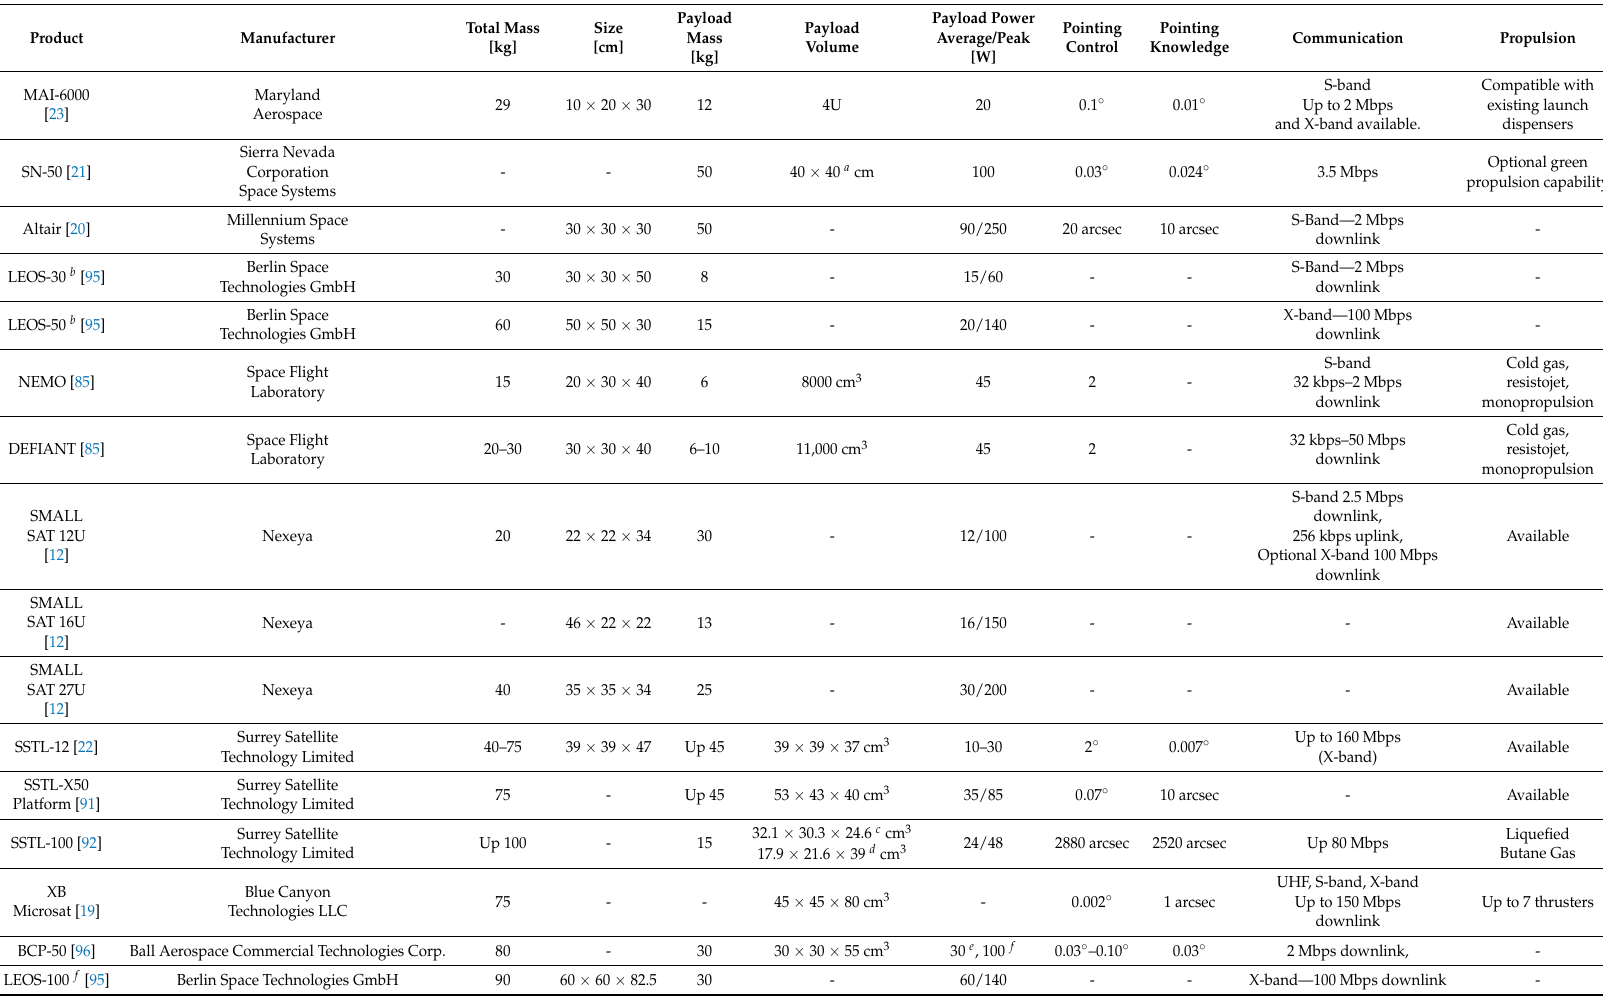
Table A2. Survey of available micro-satellite platforms for Earth